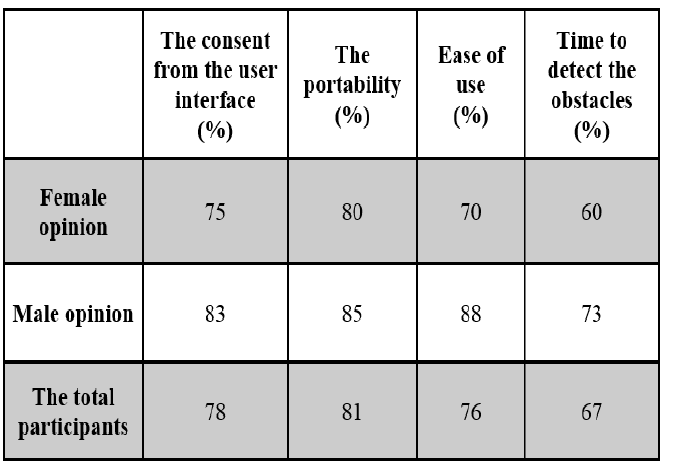
Table 1. The results of the